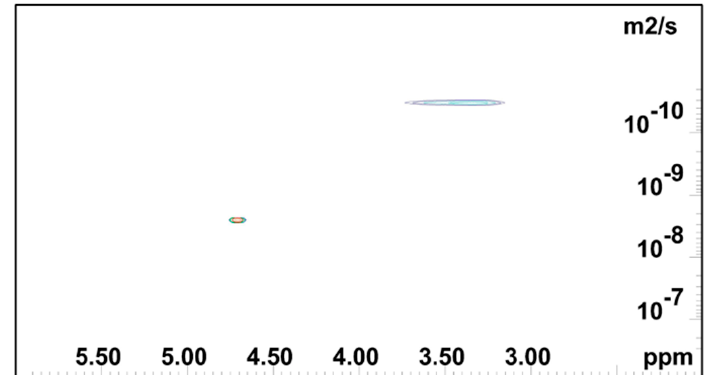
Figure 4. 2D DOSY log(D) plot for HEMC 2 mass % gel.